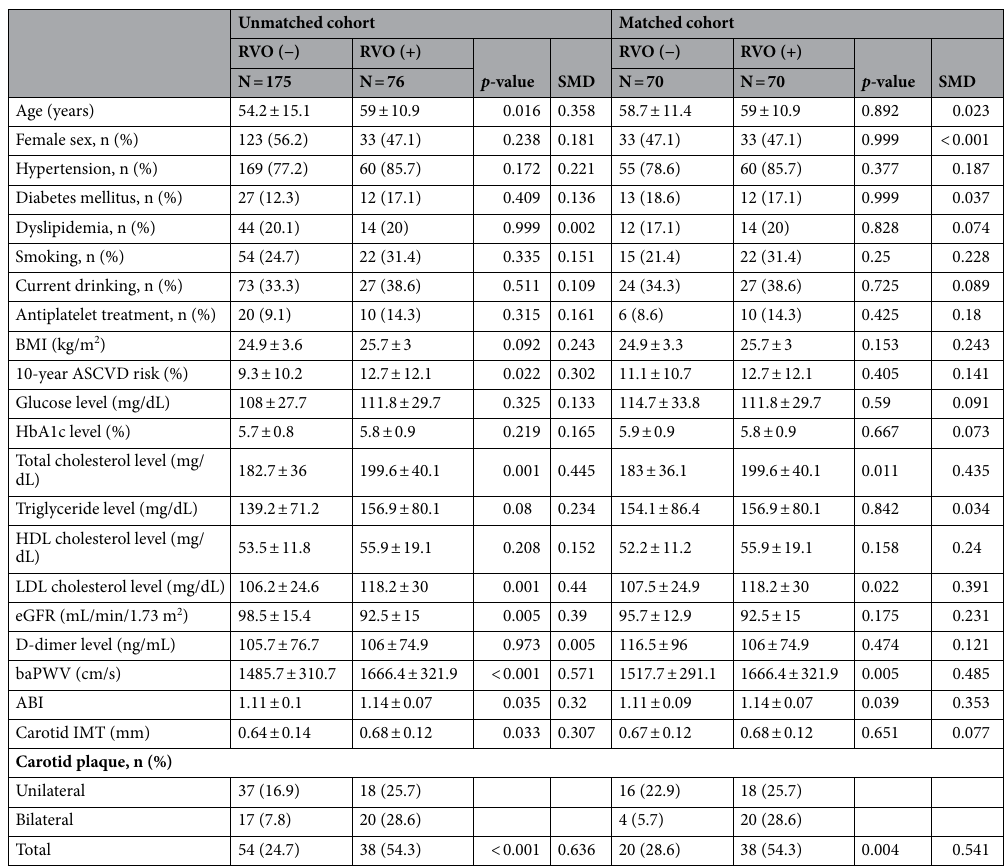
Table 1. Baseline characteristics. ABI ankle-brachial index, ASCVD atherosclerotic cardiovascular disease, baPWV brachial-ankle pulse wave velocity, BMI body mass index, eGFR estimated glomerular